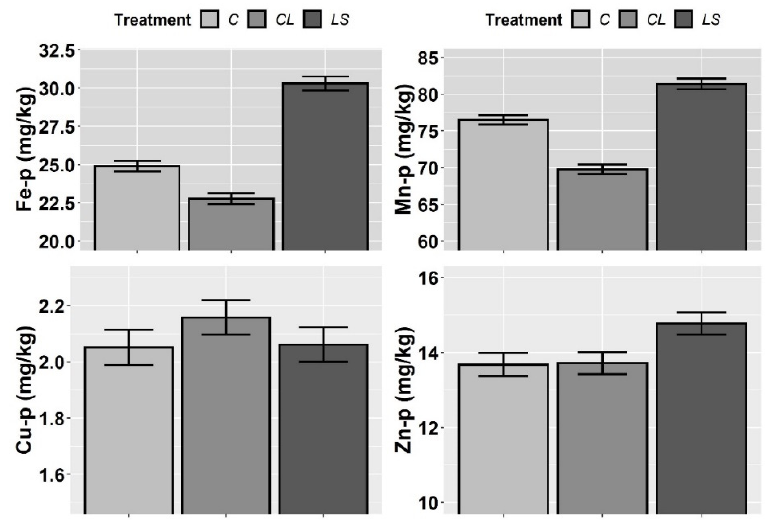
Figure 5. Mean values of the petiole nutrient contents of phosphorus (P ‐ p) and potassium (K ‐ p) for each treatment. Treatments: control (C), control of leonardite (CL), and leonardite mixed with fer ‐